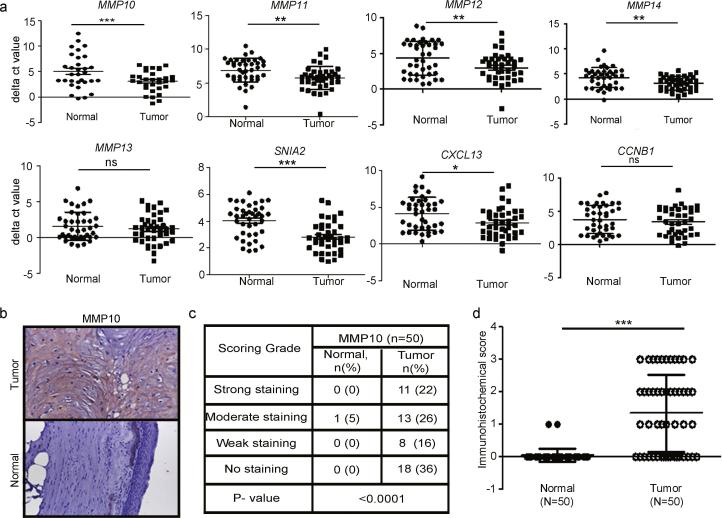
qRT-PCR validation of MMPs and immunohistochemical analysis of MMP10 in early stage tongue cancer. (a) qRT-PCR analysis of MMP11, MMP12, MMP13, MMP14, CXCL13, CCNB1, and SNAI2 transcript expression in paired normal early tongue tumors (n = 35). Dot plot representation of ΔCt value distribution and its significance between normal and tumors tongue tissue samples for MMP10. Each dot represents the average normalized ΔCt value of a gene in a single sample. Median with interquartile range is shown for each gene for normal and tumor samples. P-value is denoted as *; P < 0.01, **; P < 0.001, ***; P < 0.0001. (b) Representative IHC stained photomicrographs of tongue tumors and normal samples. The brown color indicates positive expression of MMP10 protein. (c) The tabular representation of different immunohistochemical scores grades of MMP10 in early tongue tumors. P-value is denoted as ***; P < 0.0001. The P-value was calculated by Mann-Whitney U test using GraphPad Prism 5 program and P-value ≤0.05 was considered as a threshold for statistical significance. (d) Dot plot representation of immunohistochemical score of MMP10 expression in tongue tumors and adjacent normal tissues (n = 50). Each dot represents that final IHC score for each sample and median with interquartile range is shown. Median with interquartile range is shown for MMP10 protein expression in normal and tumor samples. P-value is denoted as ***; P < 0.0001.